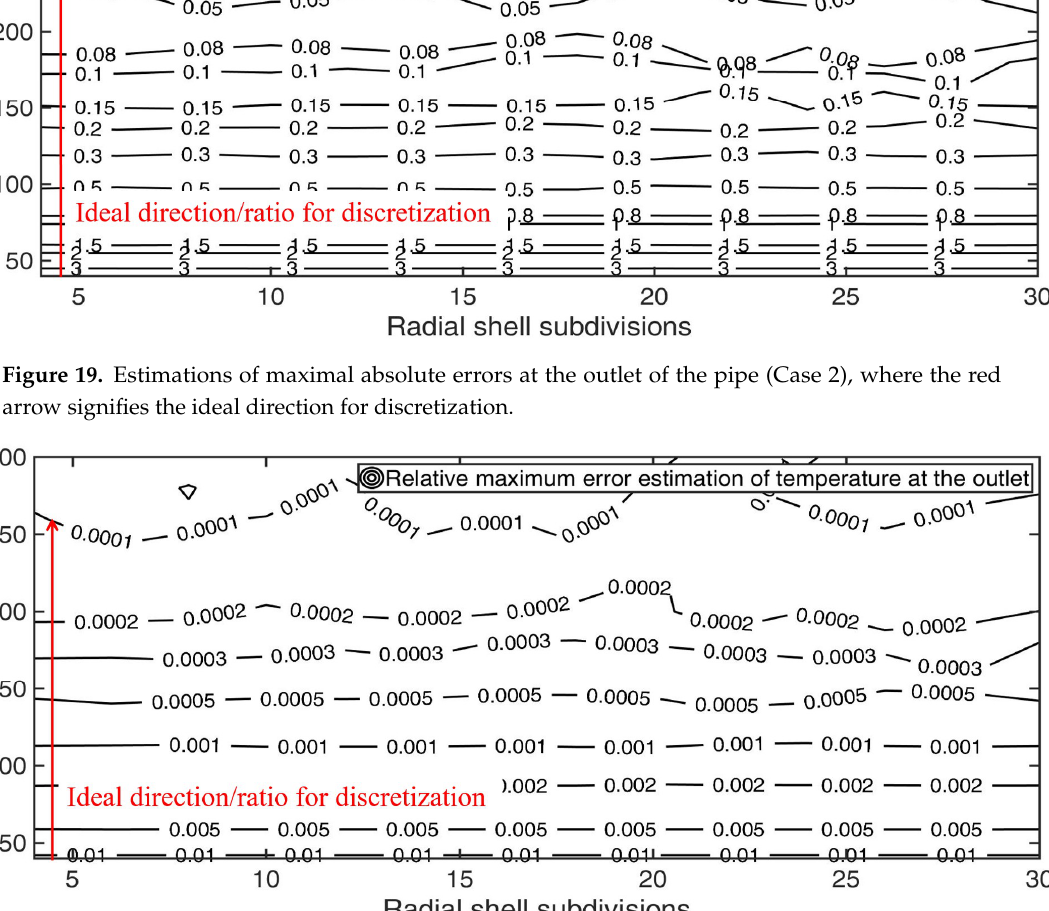
Figure 21. Computation times of the composite model tests (Case 2). The Figure 22 demonstrates the effect of the strong accumulation using the outlet temperature perspective. The above results deal with the model alone. Unfortunately, real data were not available to the authors to validate the model properly. The model is at least compared (partially validated) to a very fine model developed in Fluent (axisymmetric 2D in Figures 23 and 24) and STAR-CCM+ (fully 3D in Figures 25 and 26). The tolerance of the new model was lowered to 10 −5 and samples were saved every 10 s to demonstrate the effectiveness of the new model. The time span of the simulation was 16,000 s.